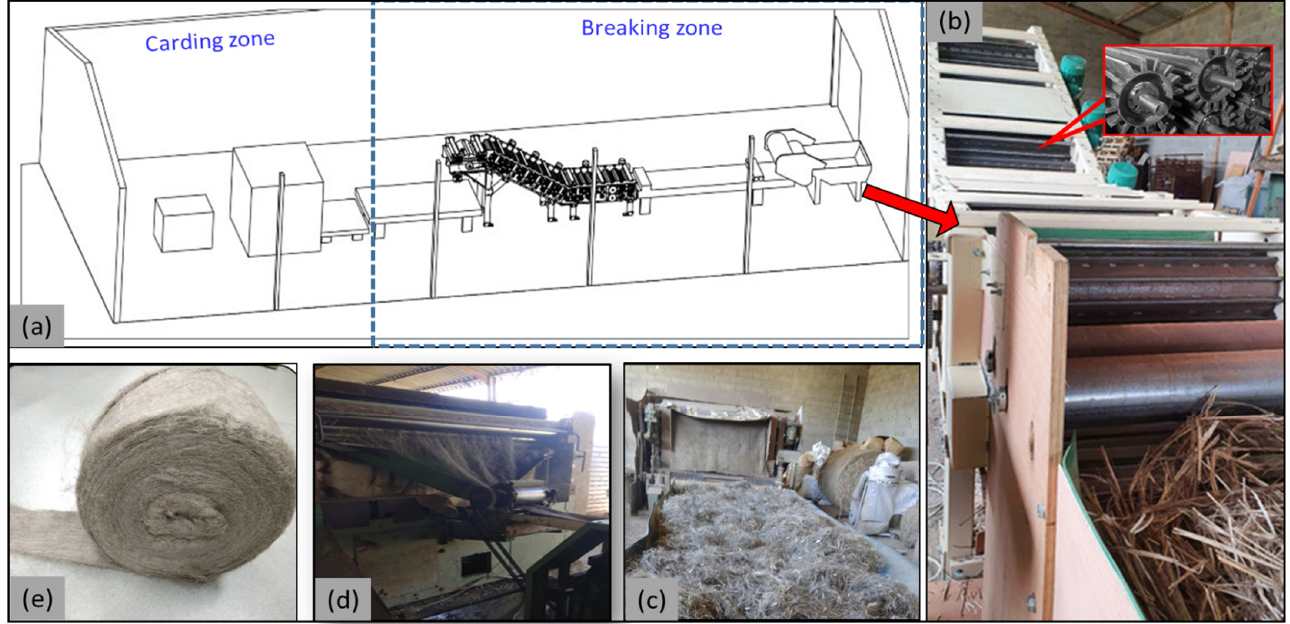
Figure 1. ( a ) General representation of the device used for method A; ( b ) front view of the breaking roller machine; ( c ) fibres at the output of the breaking roller and input of breaking card; ( d ) carded web at the output of the breaking card; ( e ) carded fibre sliver.